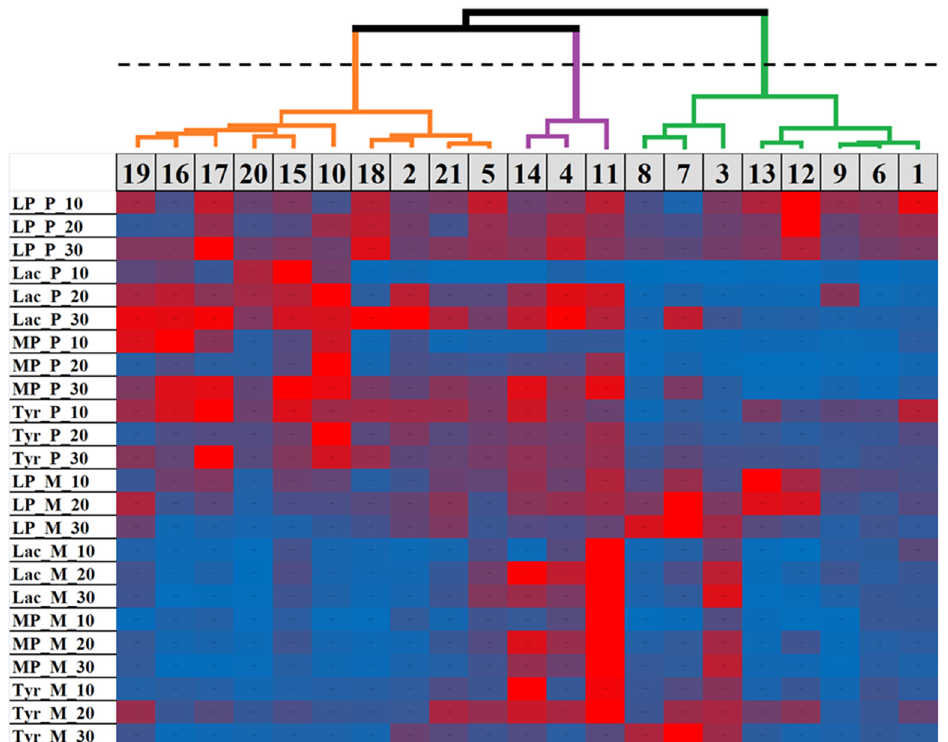
Figure 3. The Hierarchical Clustering Dendrogram combined with a heat map showing the relative patterns of extracellular lignin peroxidase (LP), Mn peroxidase (MP), laccase (Lac), and tyrosinase (Tyr) activities of different Microdochium nivale strains, designated by numbers on a gray background. Strains were grown in potato sucrose broth medium (P) or minimal medium (M) for ten (10), twenty (20), or thirty (30) days. The colors correspond to the level of activity (red—maximum and blue—minimum) relative to the activity levels of all analyzed strains. The values (colors) are normalized in relation to a given activity of different strains, but not in relation to different enzymatic activities. The heat map was made using Microsoft Excel 2010 and XLSTAT 2016.02.28451. Clustering was performed using Ward’s method; the proximity between objects was measured by the criteria of dissimilarity based on Euclidian distance. The dotted line shows the cut-off for the depth of analysis (three clusters).